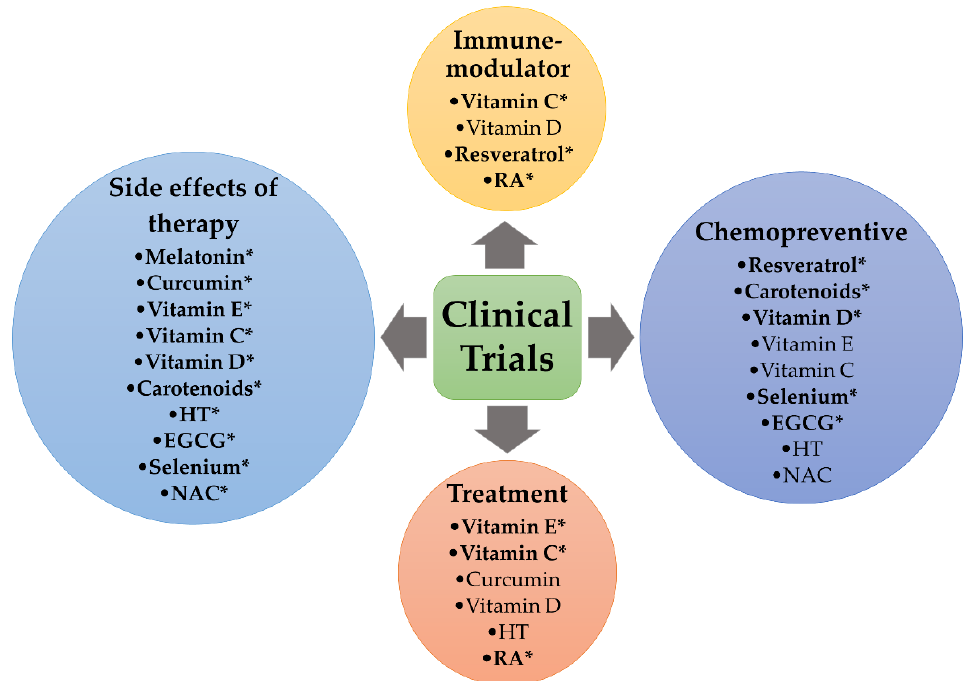
Figure 1. Antioxidants studied in clinical trials in breast cancer patients based on their properties as chemopreventives, adjuvants in treatments, and modulators of the immune system and therapy-derived side effects. Asterisk (*) indicates that a given property has been confirmed in clinical studies. Epigallocatechin gallate (EGCG); hydroxytyrosol (HT); N-acetyl cysteine (NAC); retinoic acid (RA).